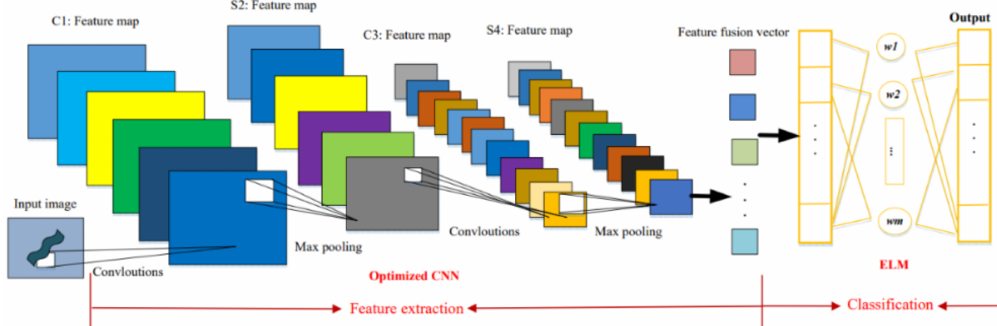
Figure 4. The innovative classification model of